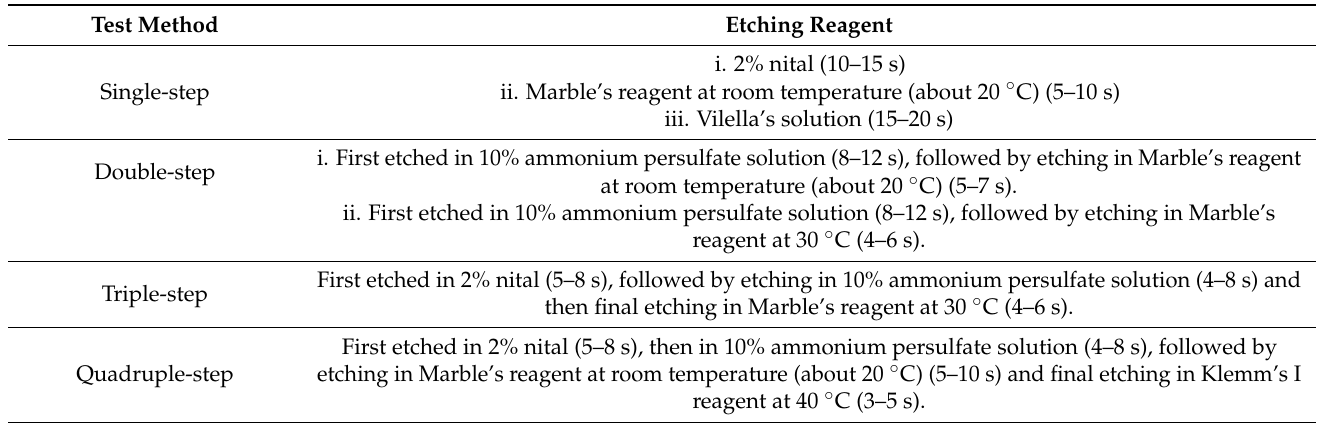
Table 3. Color metallography methods based on various etching